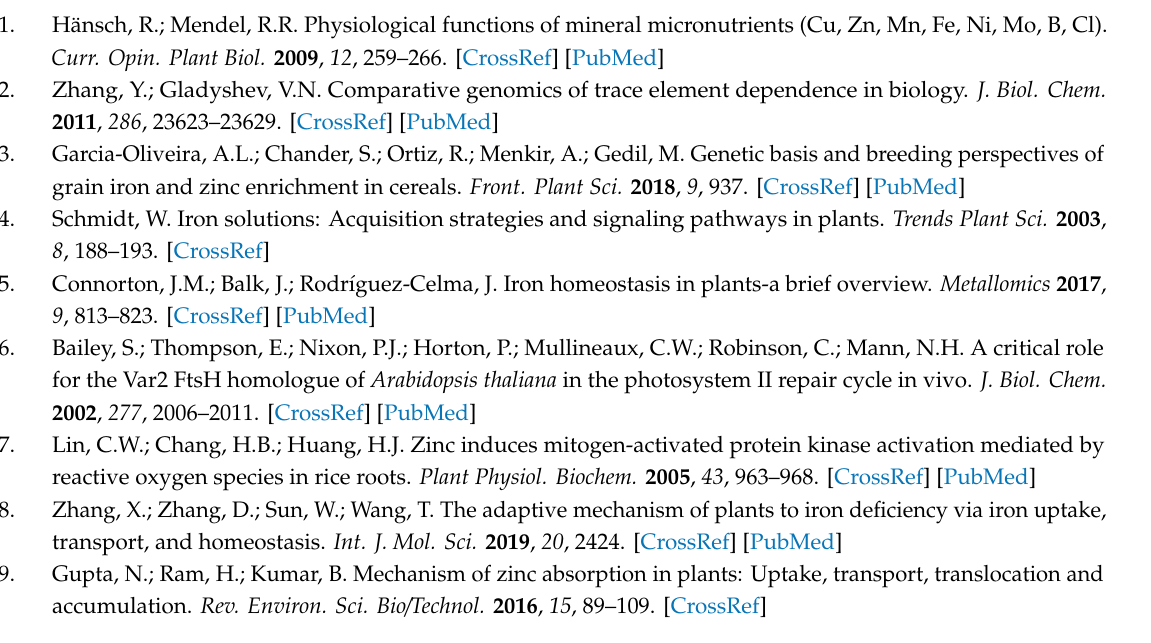
Table S1: 172 Arabidopsis and rice genes for Fe and Zn traits. Table S2: 436 unfiltered wheat orthologs of Arabidopsis and rice genes for Fe and Zn traits. Table S3: 254 filtered wheat orthologs of Arabidopsis and rice genes for Fe and Zn traits. Table S4: 11 cloned genes for wheat Fe and Zn traits. Table S5: 140 quantitative trait loci detected by linkage mapping or association analyses for wheat Fe and Zn